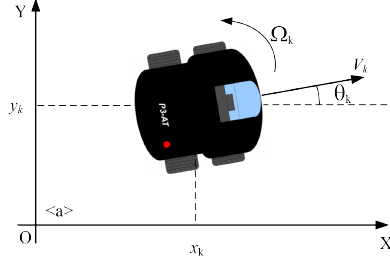
Figure 7. The robot model used in this